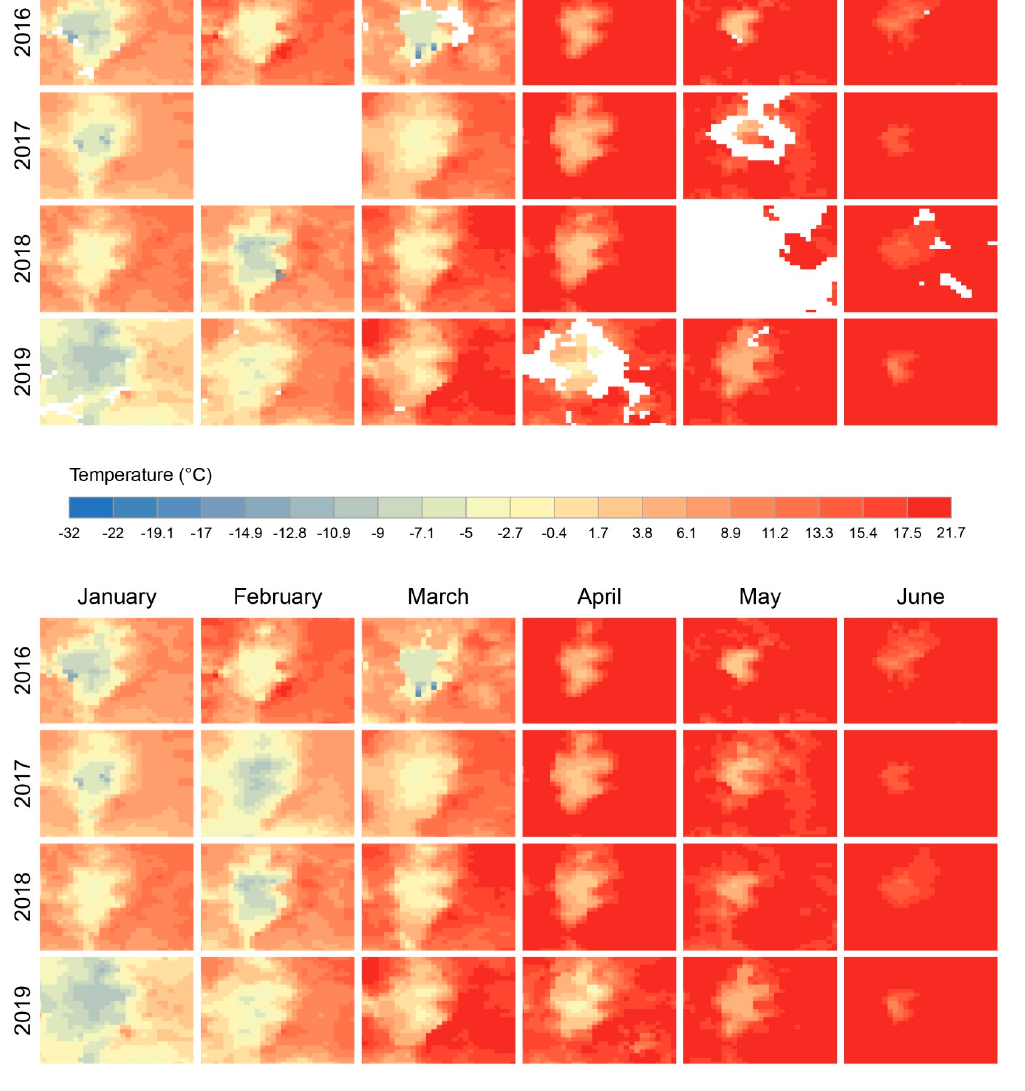
Figure 6. Examples of Land Surface Temperature Daytime series in a mountainous area (above) with blank representing the NoData pixels. Below: images of the same area and dates, with the gap-filled